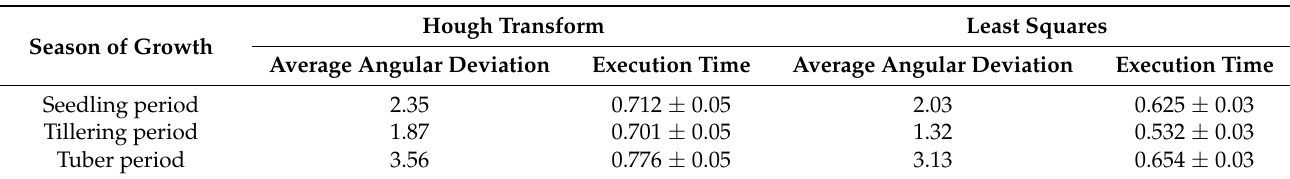
Table 5. Navigation line fitting accuracy test in different growth